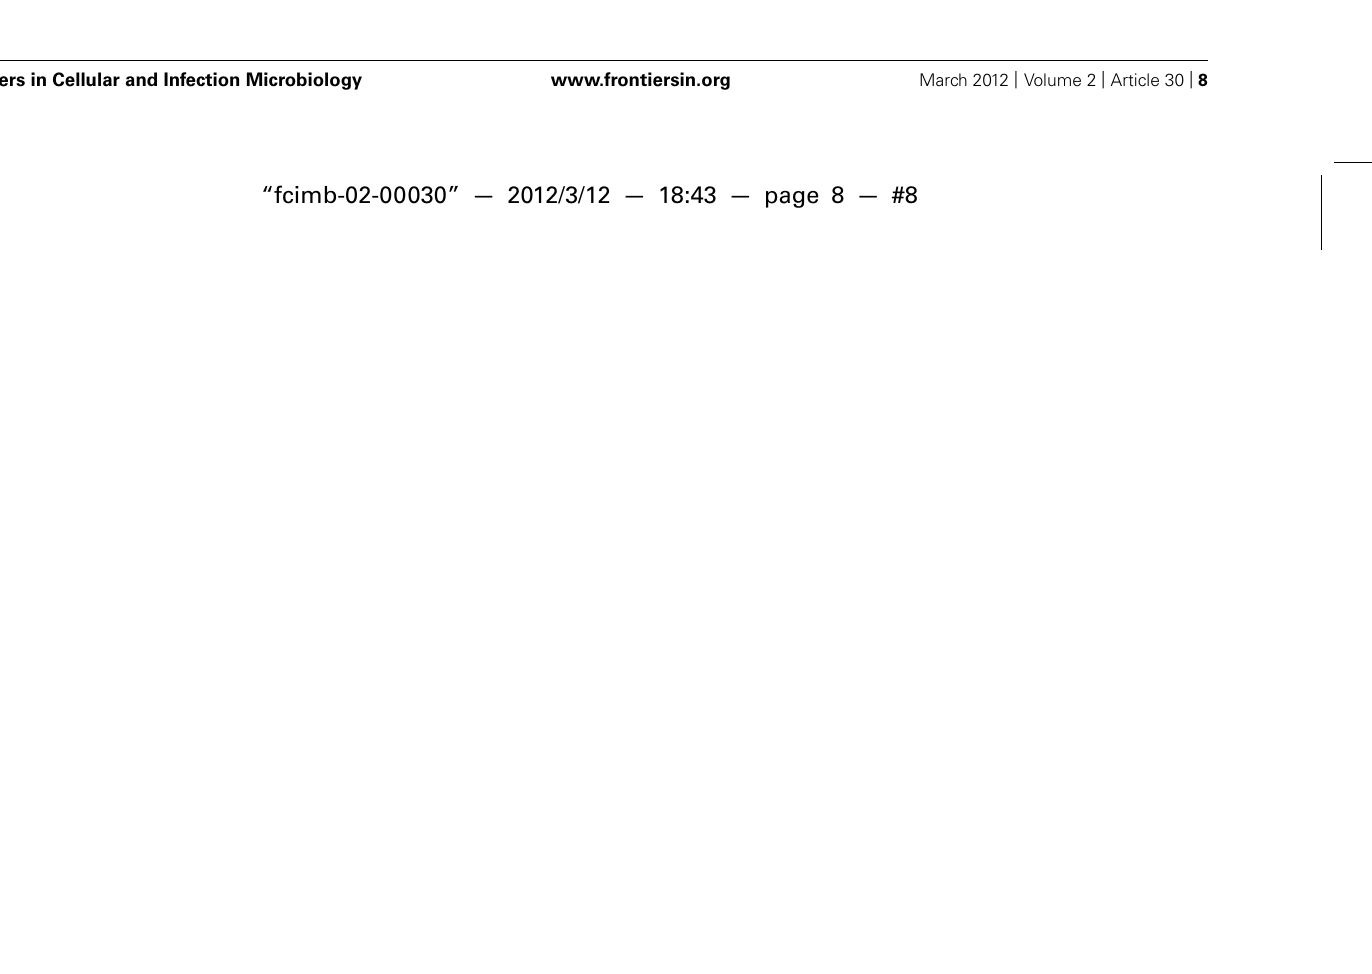
protein gel analysis of basic proteins extracted from C. jejuni strain 81-176 (c) and the pnp mutant (d) derived from this strain. Proteins were extracted from bacteria cultivated in BHI at 42 ◦ C collected when OD 600 reached